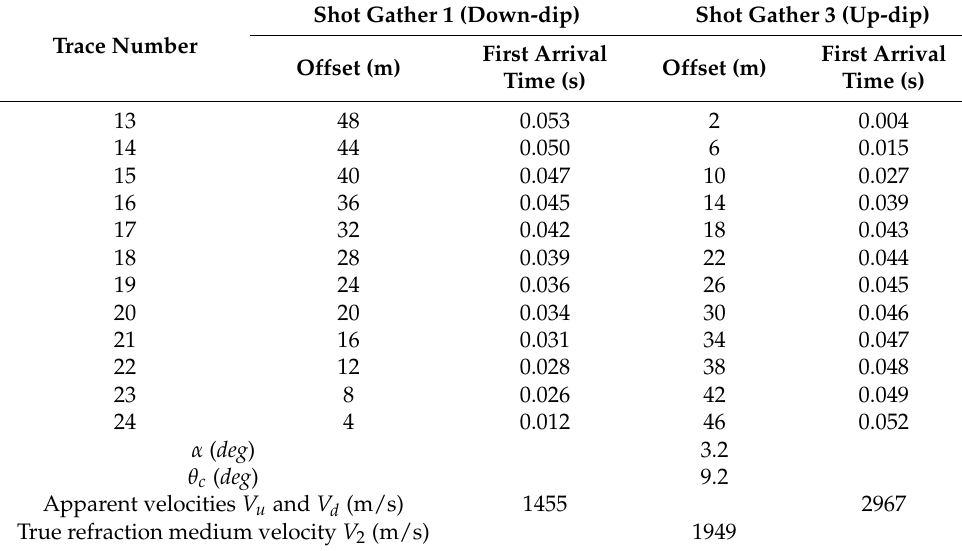
Table 2. First arrival travel times of the head wave from shot gather 1 and 3 with the values of ground-surface dip angle ( α ), critical angle ( θ c ) and refraction medium velocity ( V 2